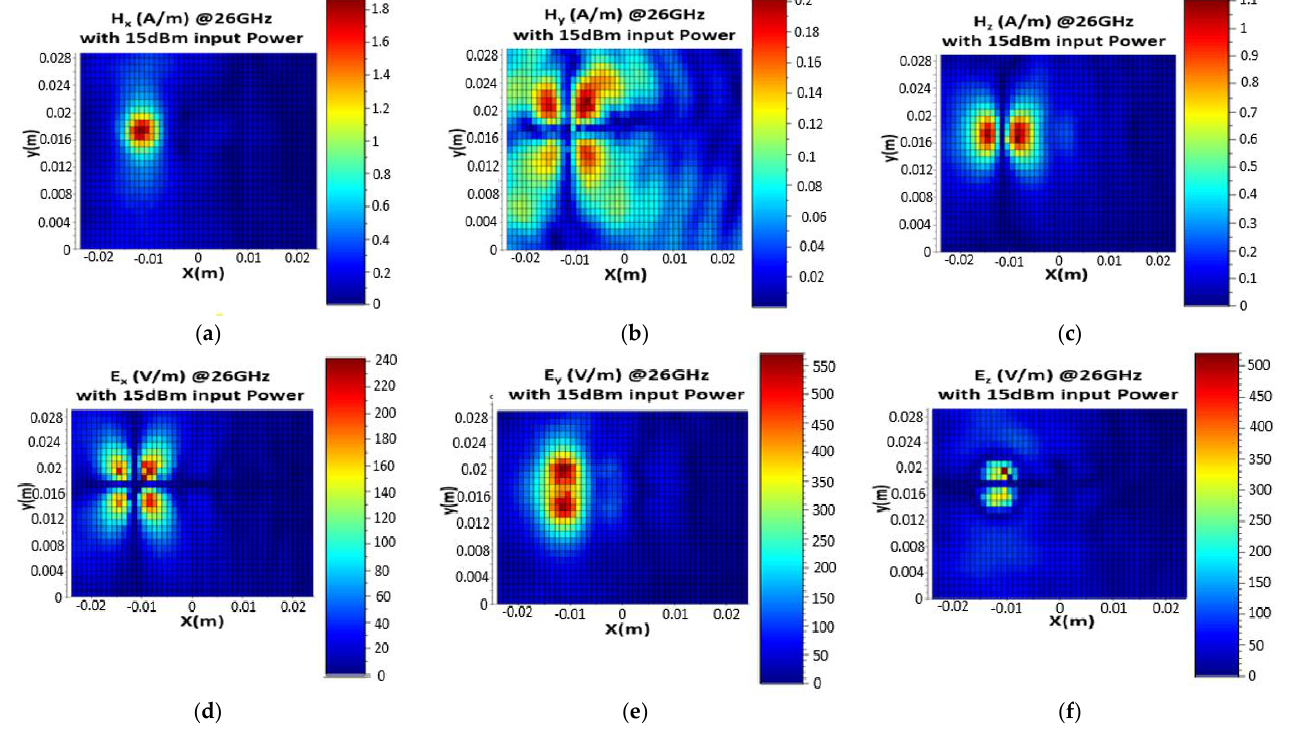
Figure 5. Magnetic field ( a – c ) and electric field ( d – f ) x, y and z components in near-field (2 mm from the DUT) at 26 GHz for 15 dBm input power.